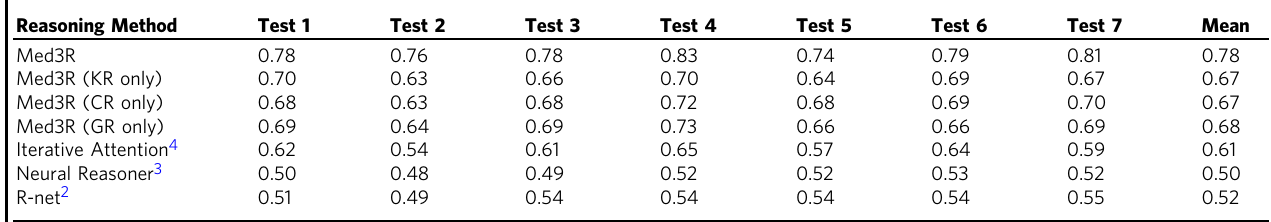
Table 1 Comparison of different reasoning methods Reasoning